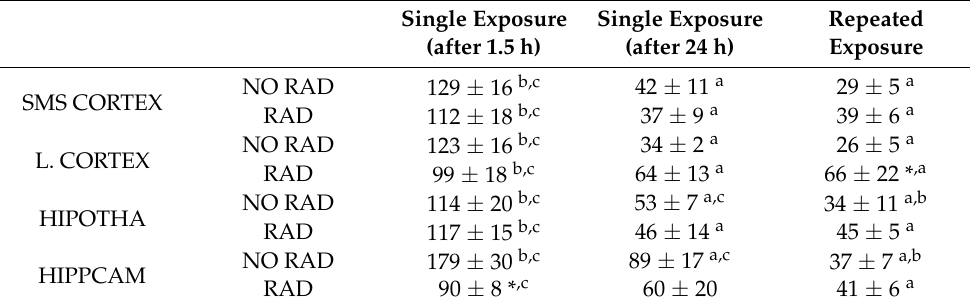
Table 1. Mean values ± SEM of cell counts that were positive for HSP-70 in brain areas: somatosen- sory cortex (SMS CORTEX), limbic cortex (L. CORTEX), hypothalamus (HIPOTHA), and hippocam- pus (HIPPCAM), with radiation and without radiation. Single Exposure (after 1.5 h)